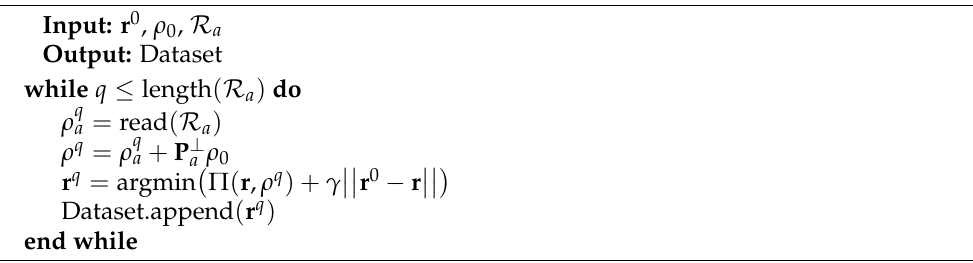
Algorithm 1 Configurations dataset generation